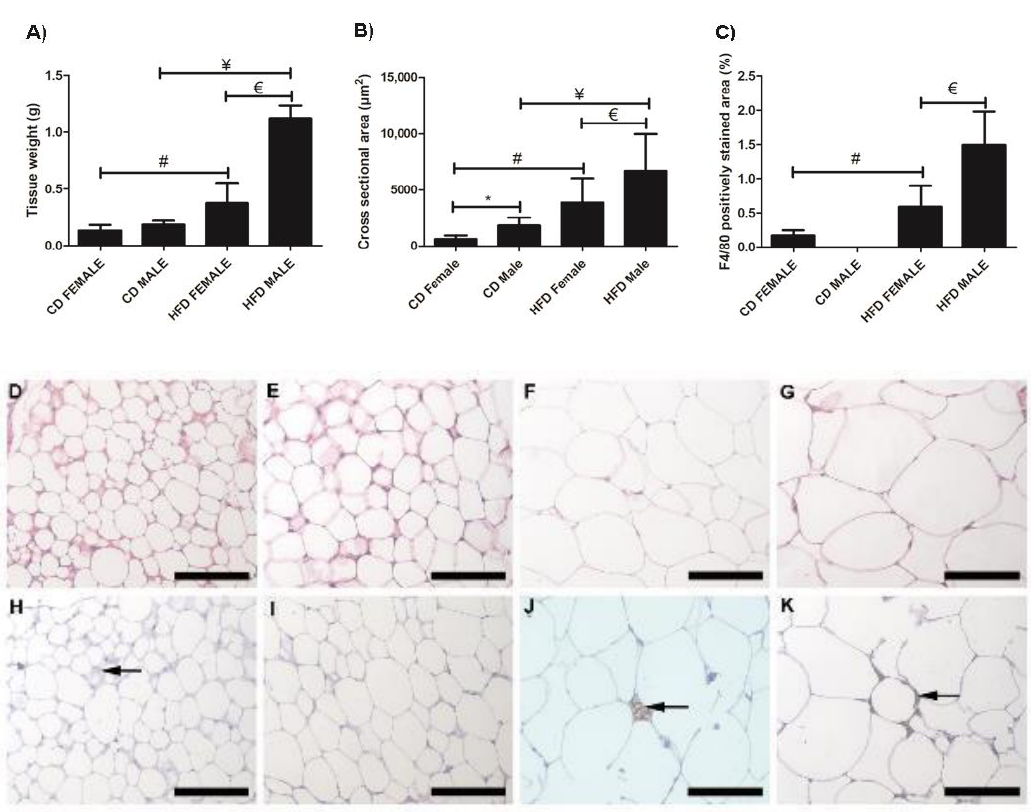
Figure 2. Histology and immunohistochemistry of iWAT sections. Weight of iWAT sections, ( A ); cross sectional area of adipocytes, ( B ); and F4/80+ macrophage-stained area, ( C ). Histological sections showing adipocyte sizes in CD females, ( D ); CD males, ( E ); HFD females, ( F ); and HFD males, ( G ). Adipocyte hypertrophy was evident in HFD males and females, compared to the CD males and females. F4/80+ immunostained sections from the CD females, ( H ); CD males, ( I ); HFD females, ( J ); and HFD males, ( K ). Macrophage infiltration (black arrow) was evident in CD females, ( H ); HFD females, ( J ); and HFD males, ( K ). No macrophages were observed in CD males, ( I ). Significantly greater macrophage infiltration was observed in HFD animals. * Significant difference between CD females and CD males, p < 0.05. # Significant difference between CD female and HFD female, p < 0.05. ¥ Significant difference between CD male and HFD male p < 0.05. € Significant difference between HFD female and HFD male, p < 0.05. Mean ± SD. Scale bar: 100 µm.